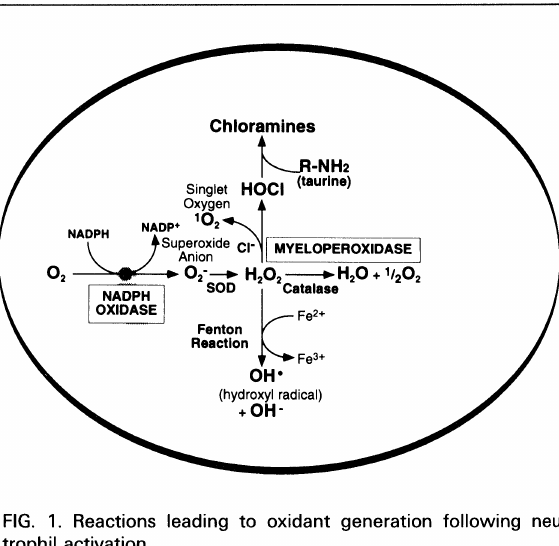
FIG. 1. Reactions leading to oxidant generation following neu- trophil